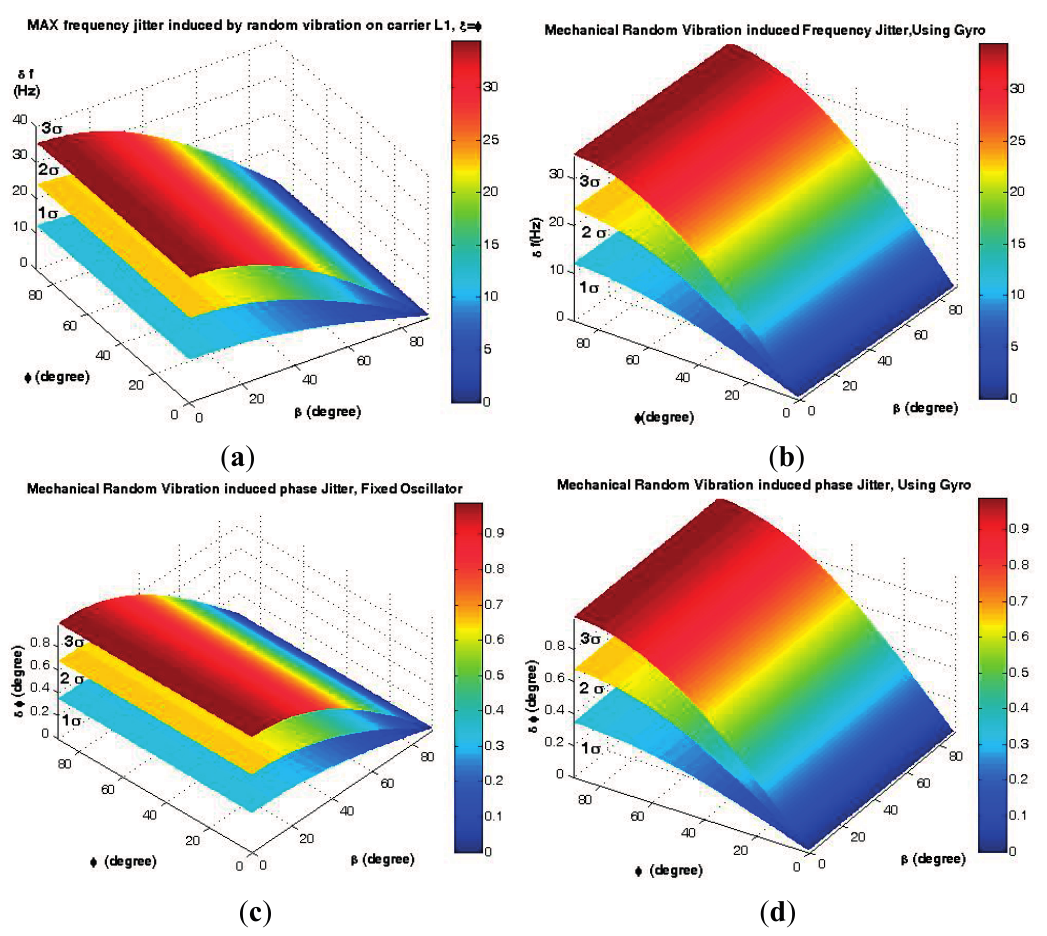
Figure 18. Time domain analysis of the disturbances induced by mechanical random vibration for ξ = φ , 0 < β < 90° and ƒ RV = 2000 Hz. ( a ) Frequency jitter of a fixed oscillator; ( b ) Frequency jitter of the gyro mounting; ( c ) Phase jitter of a fixed oscillator; ( d ) Phase jitter of the gyro mounting.